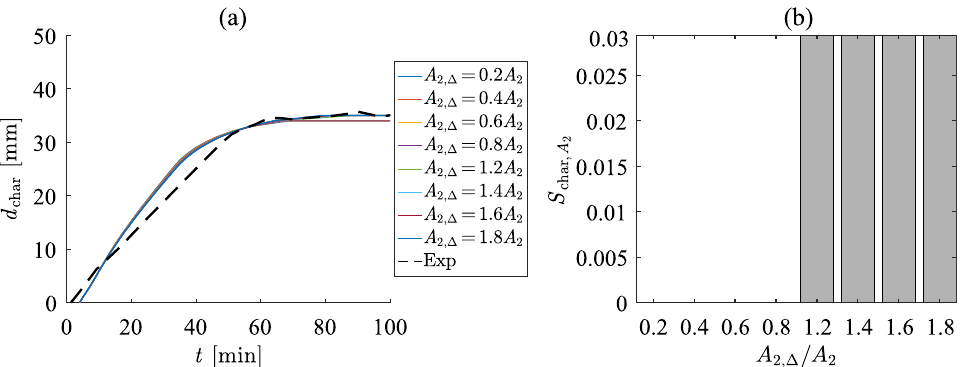
Fig. 5 a The development of charring depth for varied parameter A 2, (cid:31) . b Sensitivity index S char, A final charring